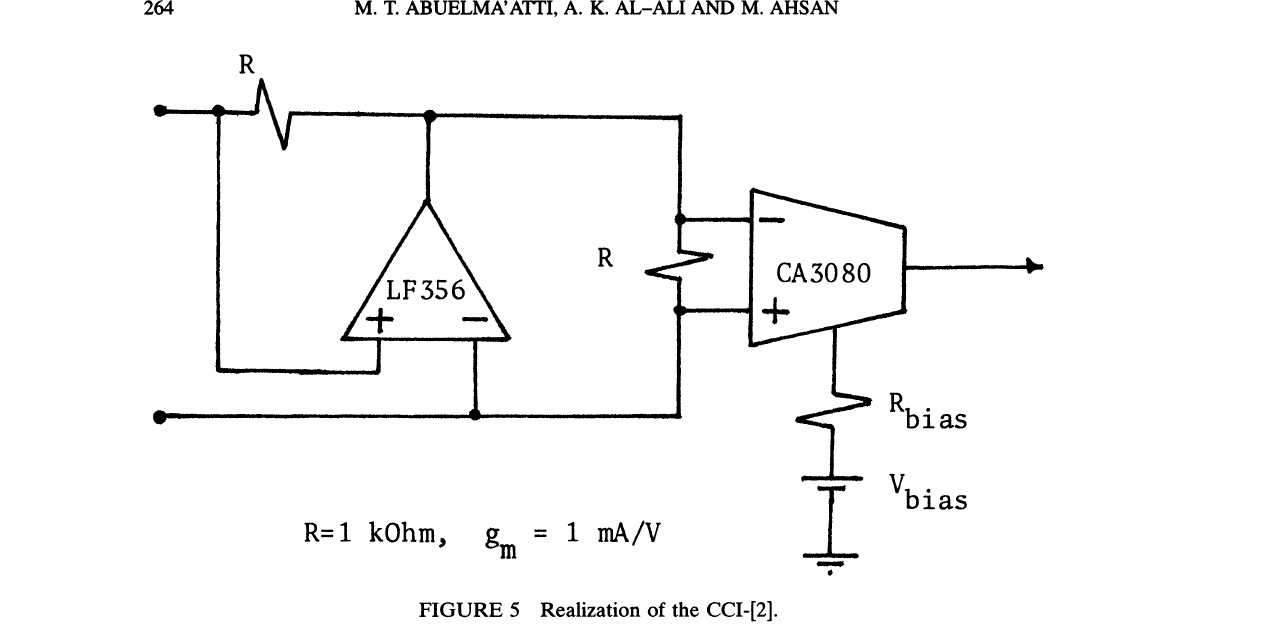
FIGURE 5 Realization of the CCI-[2].